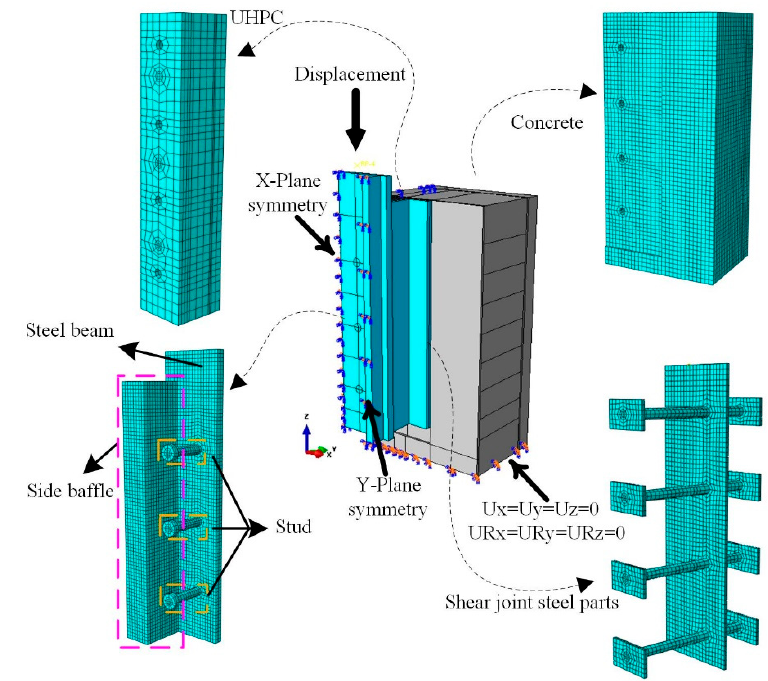
Figure 16. Modeling and boundary conditions.